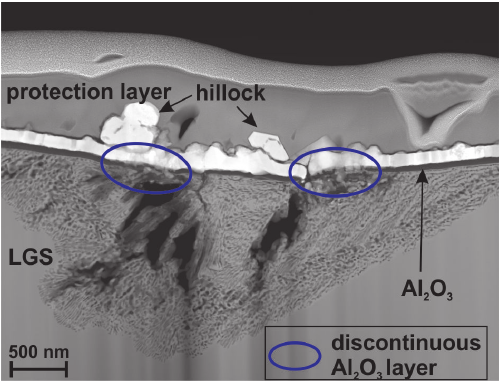
Figure 6. High-angle annular dark field scanning transmission electron microscopy (HAADF-STEM) image of the RuAl film on the pretreated LGS substrate (10 + 48 h) after annealing at 800 ◦ C for 10 h in high